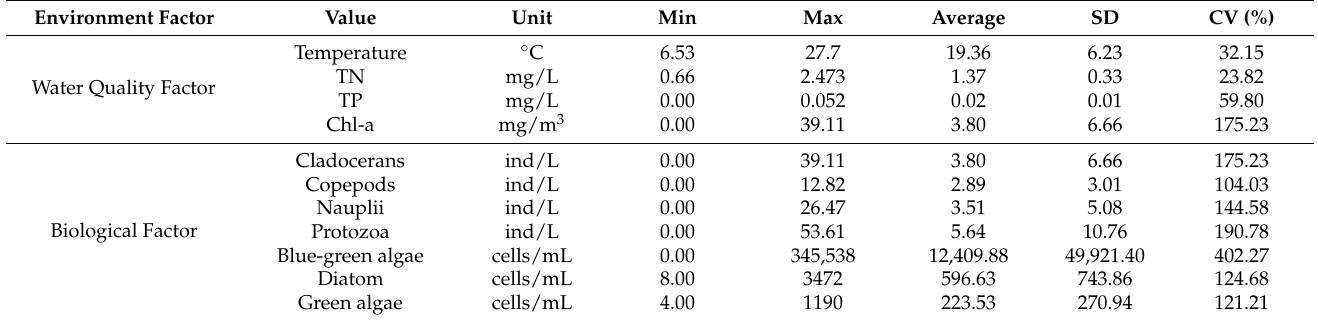
Table 1. Summary of 11 environmental factors that may influence the species composition of the rotifer community in Daecheong